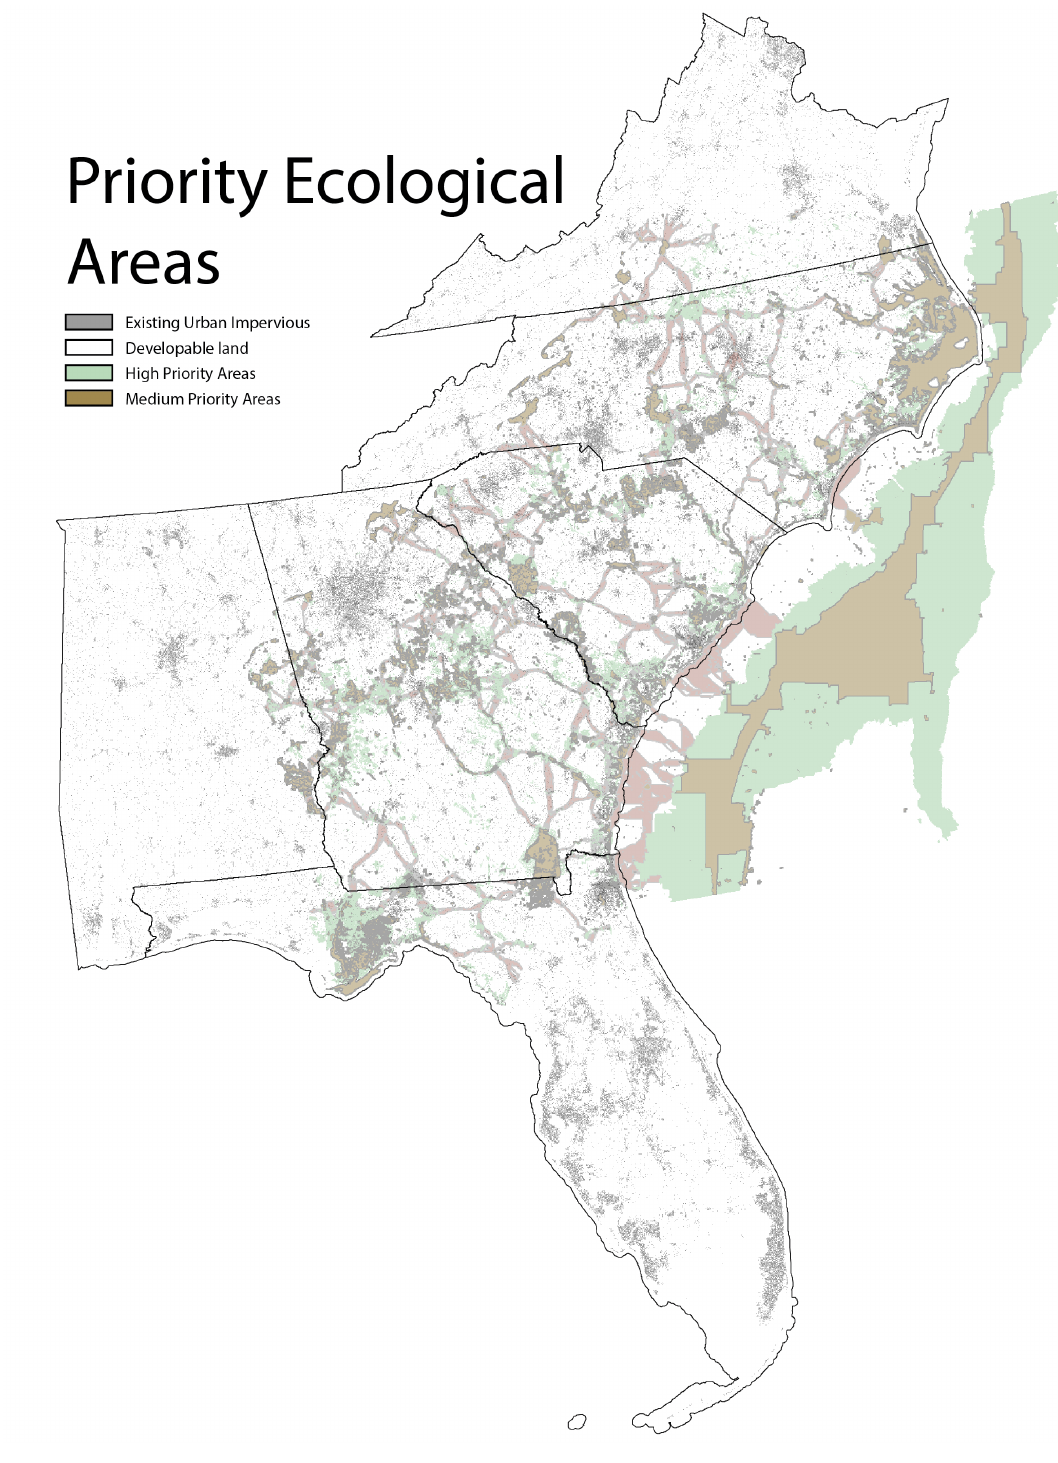
Figure A4. Lands of ecological significance